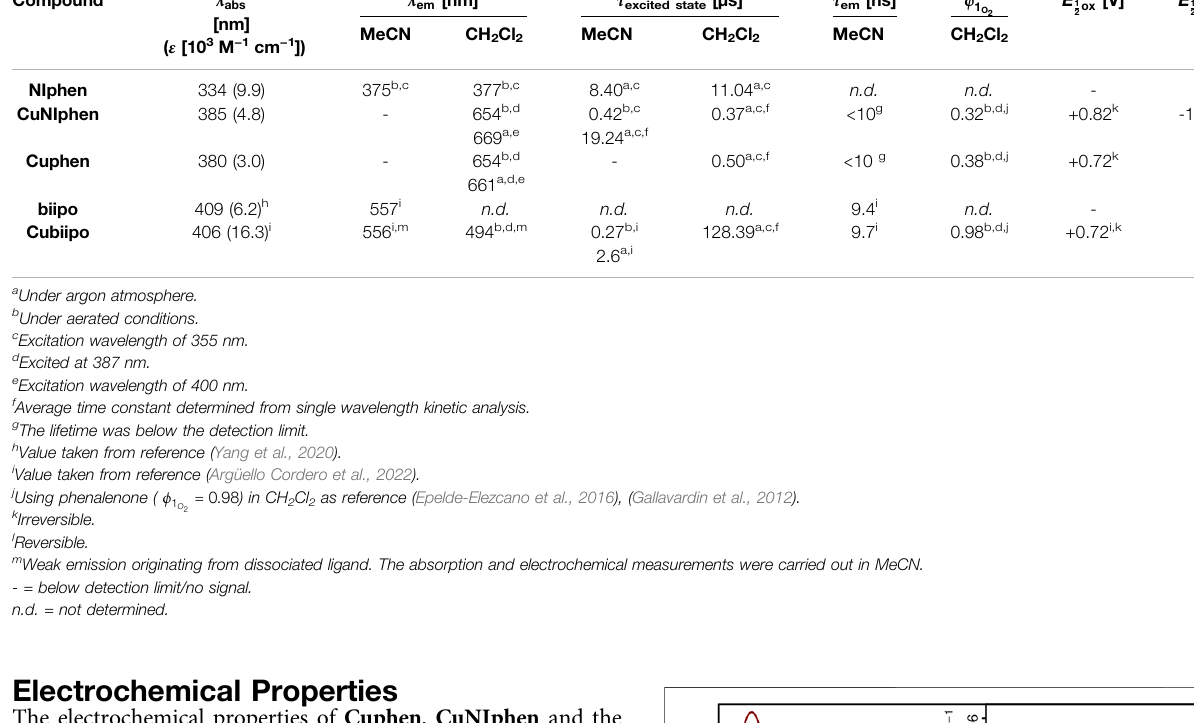
TABLE 2 | | Summary of the photophysical and electrochemical properties of NIphen , CuNIphen , Cuphen and of selected reference compounds in acetonitrile and dichloromethane solution at room temperature. The absorption measurements were carried out in MeCN solution. The electrochemical data were obtained from deaerated acetonitrile solution at room temperature and are referenced vs. the ferrocene/ferricenium (Fc/Fc + ) couple. Compound